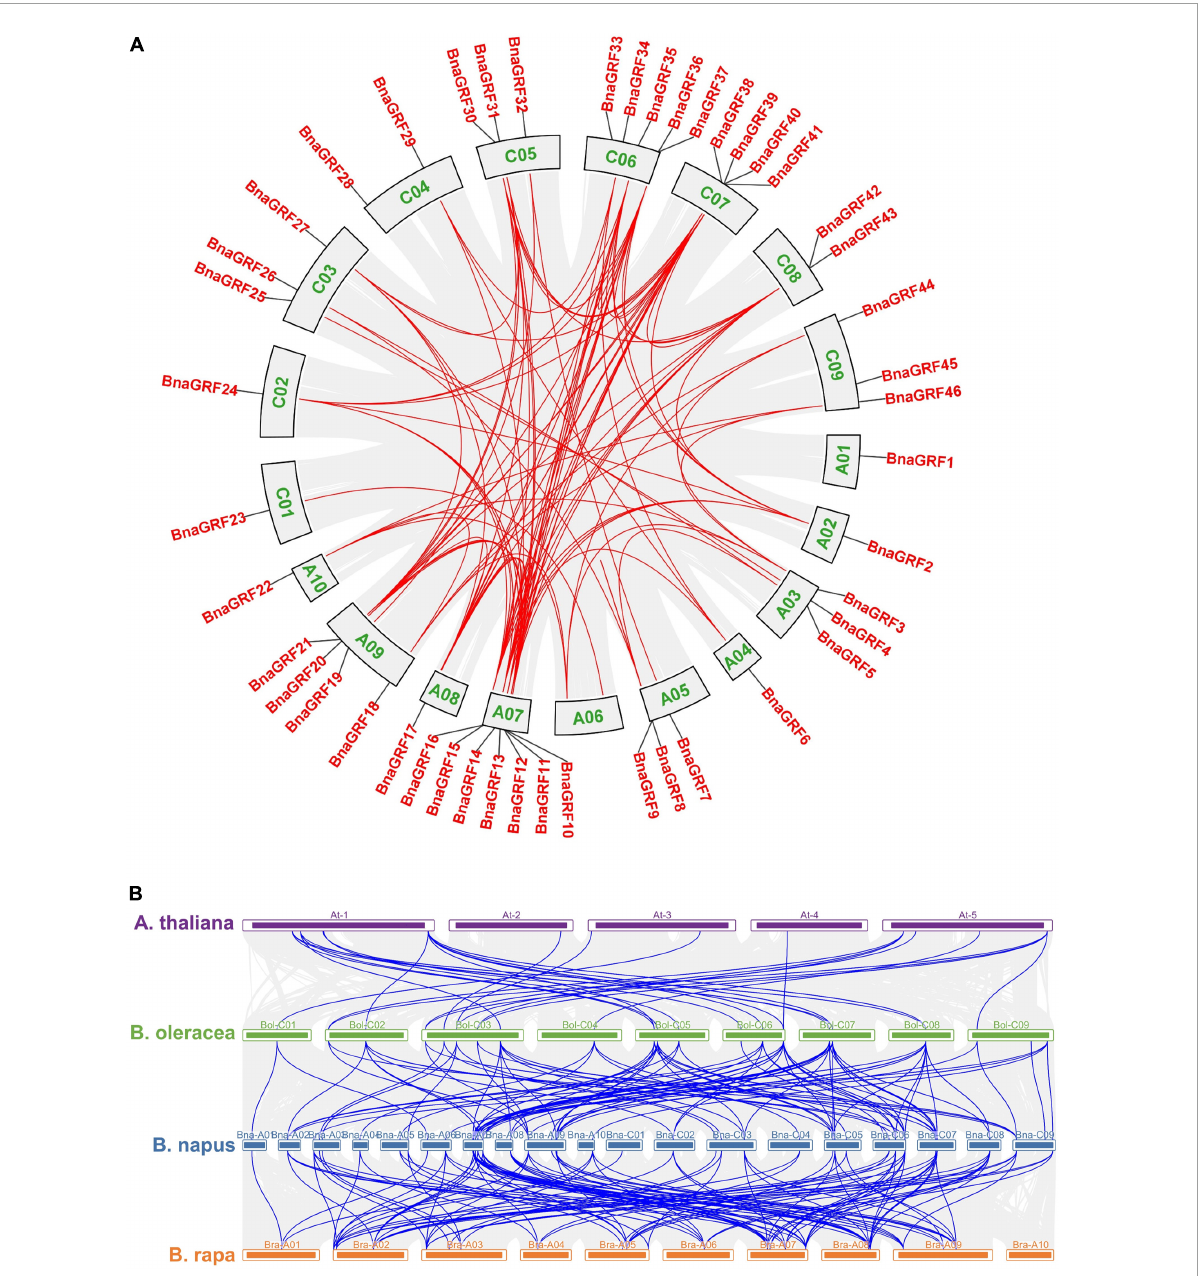
FIGURE2 Circular illustrations of the chromosomal dispersal and inter-chromosomal associations of BnaGRFs, and synteny analysis of 14-3-3 genes in B. rapa , B. oleracea , B. napus , and Arabidopsis. (A) Analysis of syntenic relationships among BnaGRF homologs. Red lines inside the schematic view denote the duplicated pairs of BnaGRFs. (B) Analysis of syntenic relationships among BraGRFs, BolGRFs, BnaGRFs, and AtGRFs. Gray line represents the syntenic block in plant genomes, and blue line represents the collinear 14-3-3 gene pair.